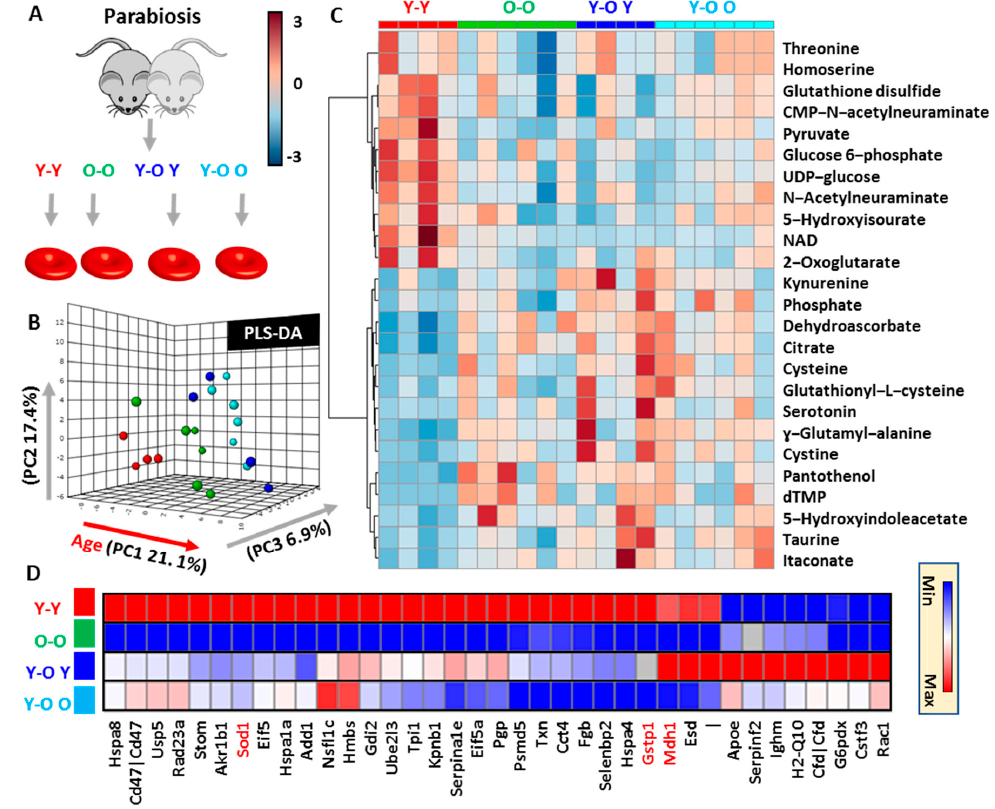
Figure 5. Metabolomics and proteomics analyses of RBCs in isochronic and heterochronic parabiotic mice. In ( A ), an overview of the experimental design. In ( B ), partial least square-discriminant analysis (PLS-DA) from the metabolomics data. In ( C , D ), top significant metabolic and protein changes in the parabiosis experiments are presented in the form of a heat